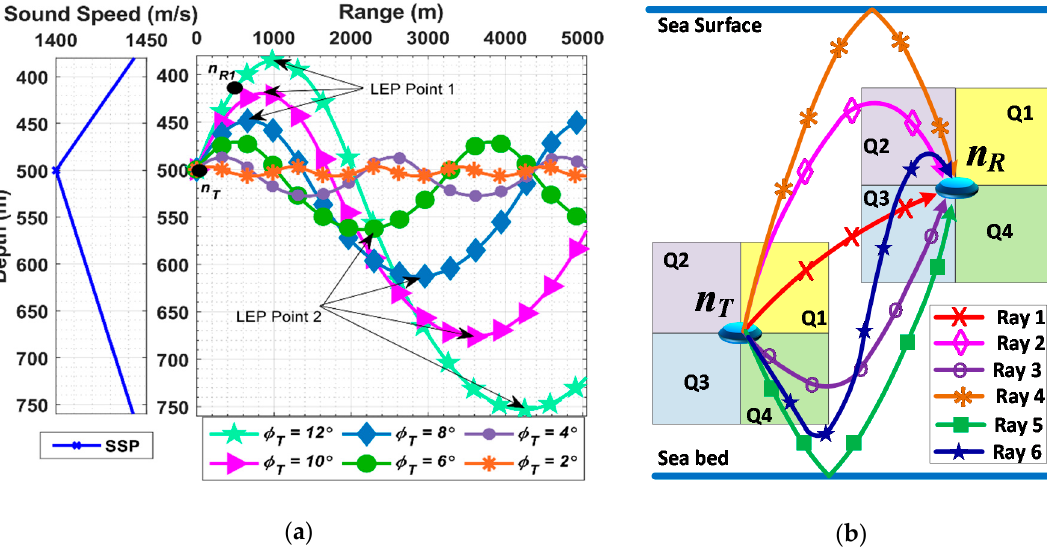
Figure 1. Di ff erent types of underwater ray configurations based on their propagation path. Part ( a ) illustrates the simulation results of Bellhop ray tracing algorithm for transmitted signals at small angles in the extreme SSP gradients shown on the left, while part ( b ) shows (i) a direct ray (Ray 1), (ii) rays with single Local Extremum Point (LEP) (Rays 2 and 3), (iii) reflected rays (Rays 4 and 5), and (iv) multi LEP rays (Ray 6).